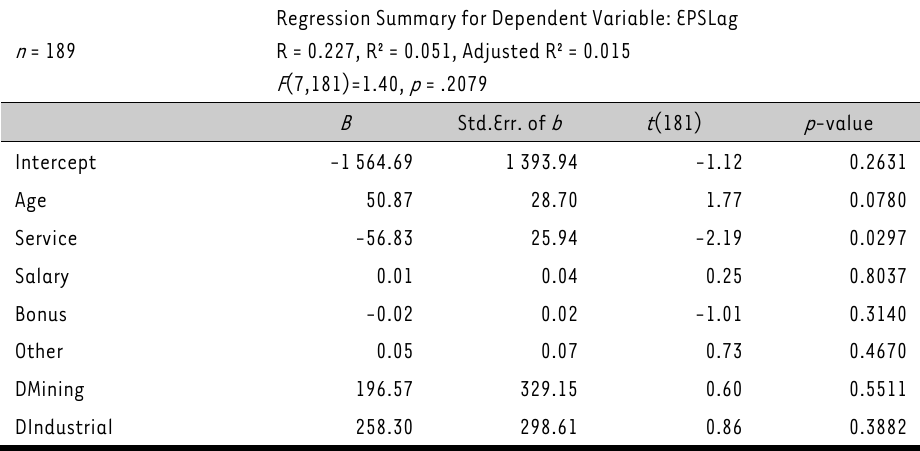
TABLE 12: Econometric Model 5 showing ROA lagged as the dependent variable Regression Summary for Dependent Variable: EPSLag n = 189 R = 0.227, R² = 0.051, Adjusted R² =